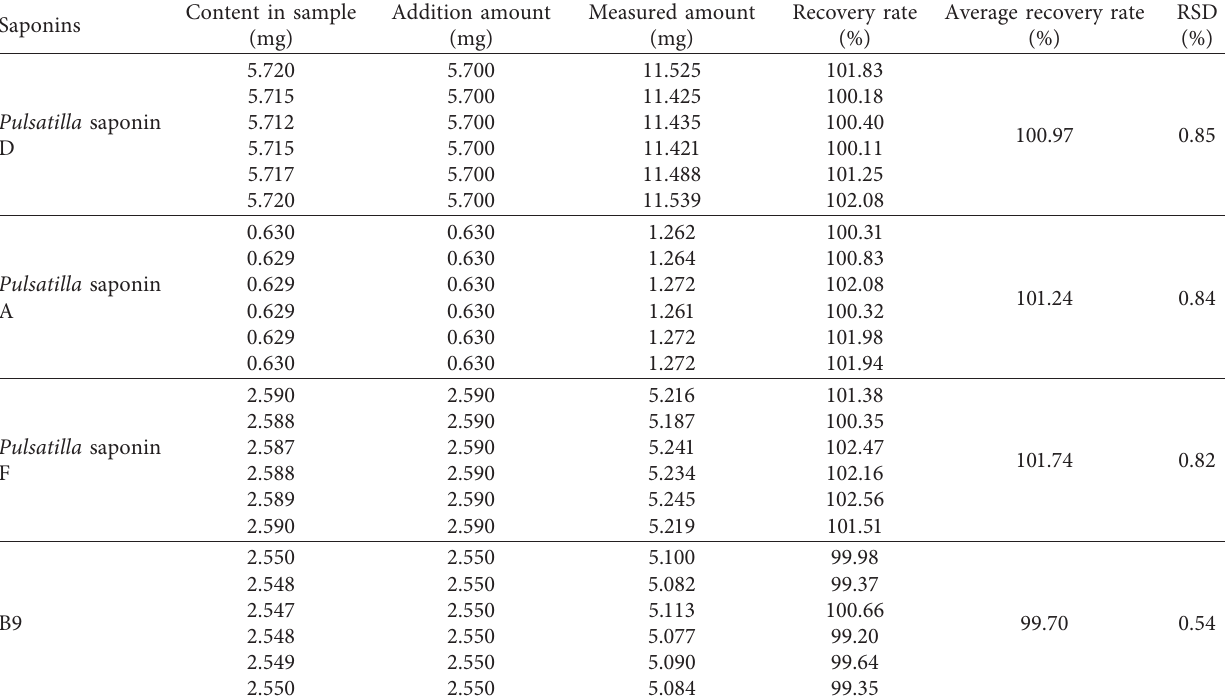
Table 7: The results of recovery.